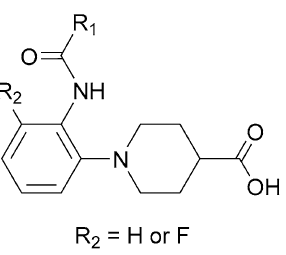
(Table 2). Compounds 2 , 3 , 5 , 8 , and 11 have the same substructure of an ortho -substituted aromatic amide with a carboxylated piperidine (Fig. 4). Of the assayed 620 compounds, 17 have this substructure, and 29.4% (5/17) of tested compounds having the substructure were hit. The common substructure does not exist in the known Keap1/Nrf2 inhibitors and rarely (< 0.001%) exist in the ChEMBL database, indicating the novelty of the five hit compounds in terms of substructure.